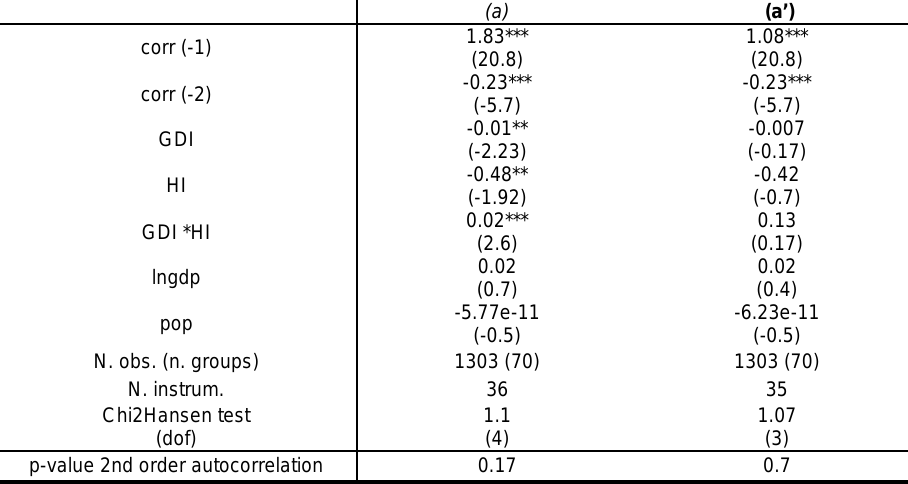
Table A4: C test. Dependent variable: Corruption